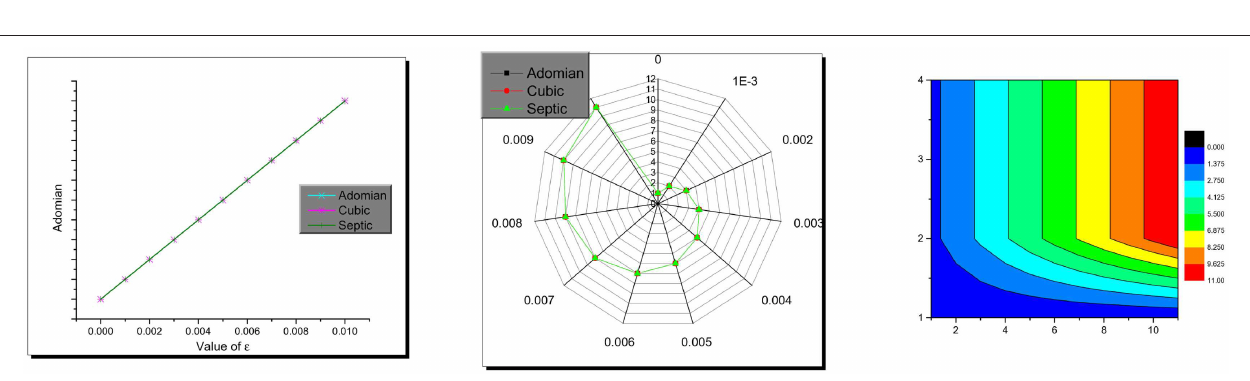
FIGURE 5 | Combined, radar, and contour plots of the absolute value of error for the Adomian, cubic, and septic schemes.